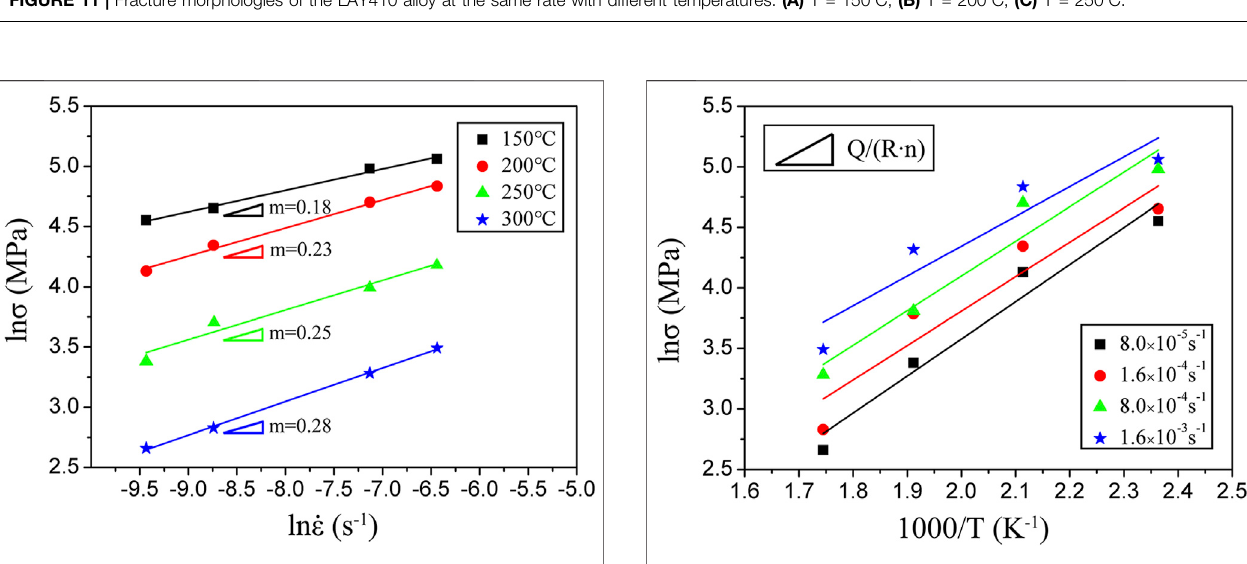
FIGURE 11 | Fracture morphologies of the LAY410 alloy at the same rate with different temperatures: (A) T (cid:2) 150 ° C, (B) T (cid:2) 200 ° C, (C) T (cid:2) 250 ° C.